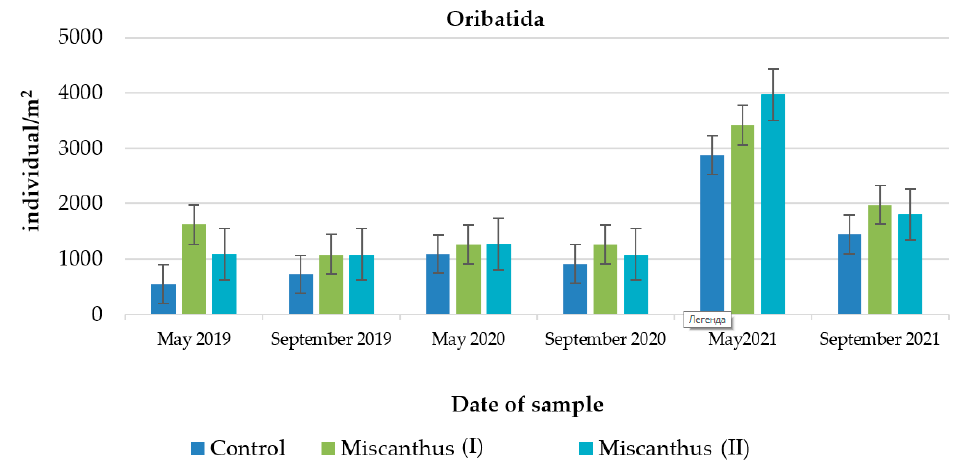
Figure 5. The number of oribatids on the studied soil under the Miscanthus : May 2019– НIР 05 = 225; НІР 05 = 354; September 2021– НІР 05 = 142. Source: own research results.